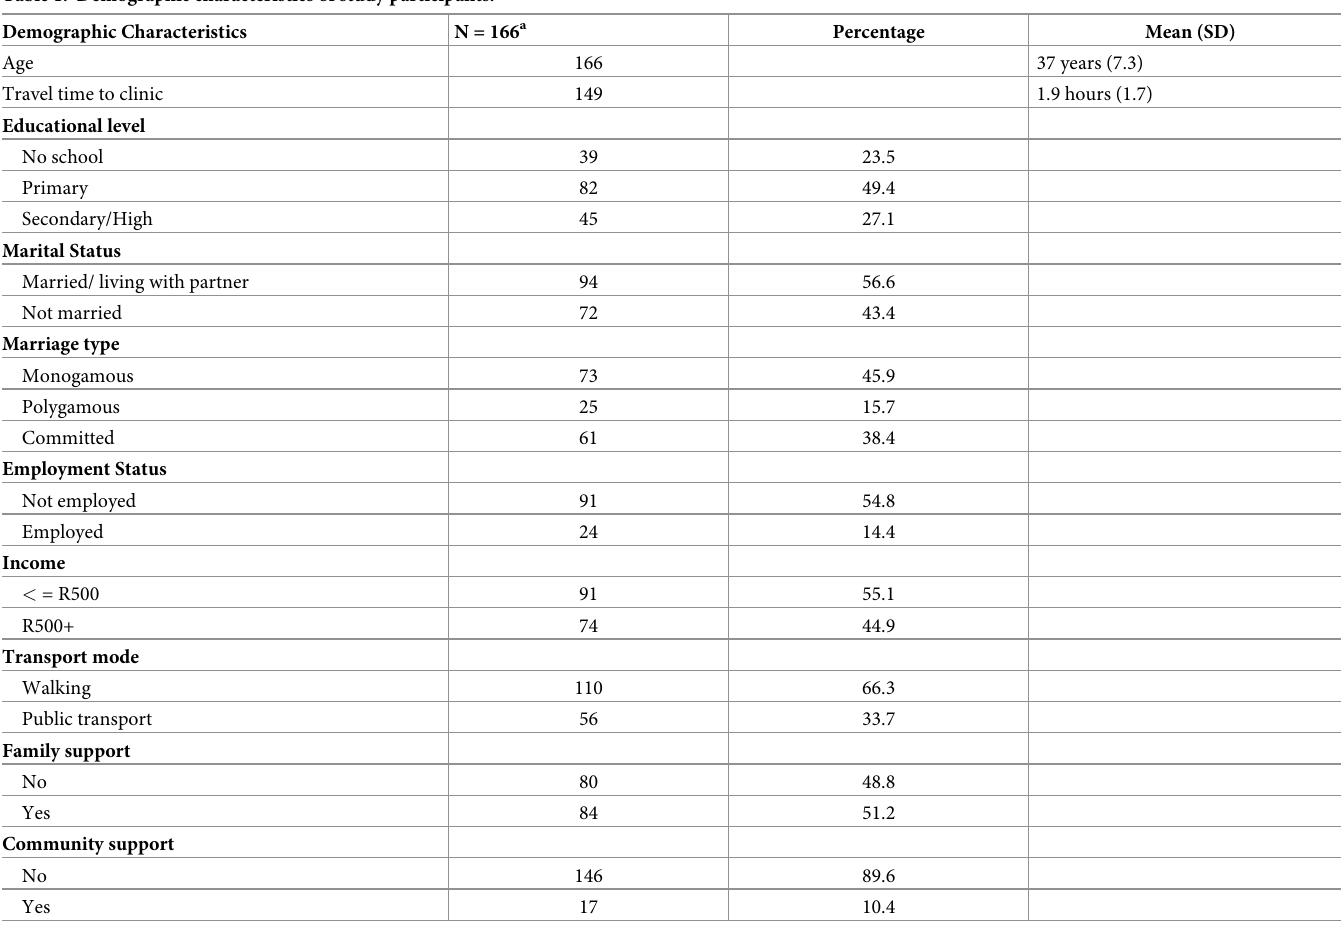
Table 1. Demographic characteristics of study